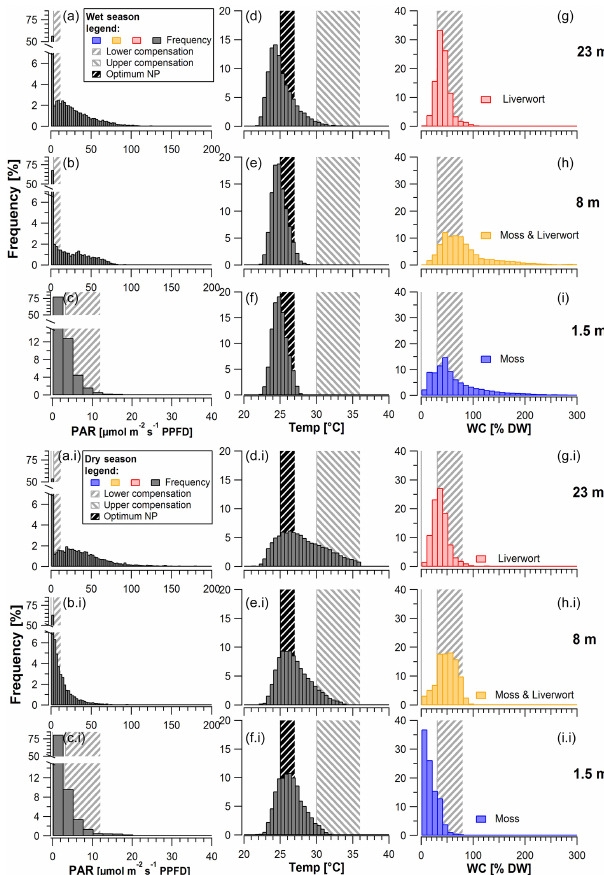
Figure 4. Frequency of mean photosynthetically active radiation (PAR; a–c, a i –c i ) , temperature (Temp; d–f, d i –f i ) , and water con- tent (WC; g–i, g i –i i ) measured on top and within bryophytes at 1.5, 8, and 23m height during (top) the wet and (bottom) the dry season. Calculation of the histograms based on 30min intervals. Shaded areas represent the ranges of reference values for lower compensation (PAR, WC), upper compensation (temperature), and the optimum (temperature) for net photosynthesis, as measured by Lösch (1994) and Wagner et al. (2013; Table S4). Bin sizes for PAR: 2.5µmolm − 2 s − 1 ; temperature: 0.5 ◦ C; WC: 10%.